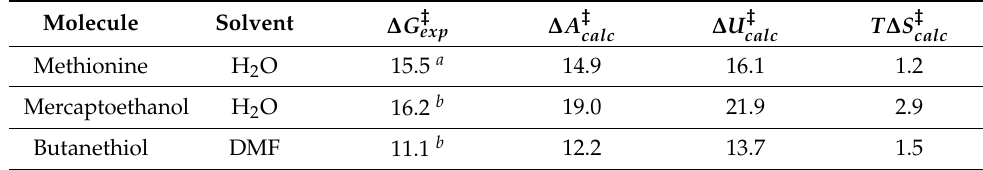
Table 1. Comparison between experimental and theoretical data of the thermodynamic properties (in kcal/mol) for the Met oxidation [34] and thiolate/disulfide interchange reaction for mercap- toethanol (OHCH 2 CH 2 SH) and butanethiol (CH 3 CH 2 CH 2 CH 2 SH) [16]. The estimated statistical